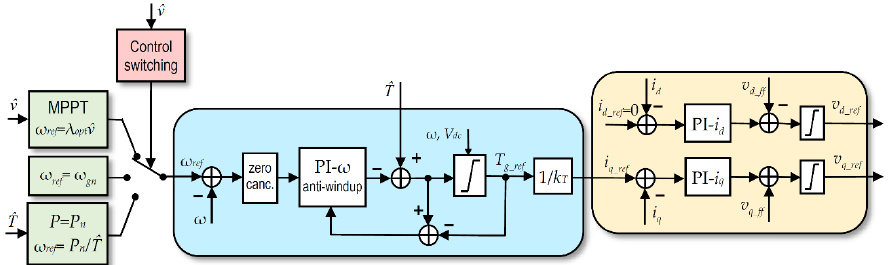
Figure 9. Rotor velocity and current controllers with variable structure setting of ω ref and compensation input of aerodynamic torque estimate T̂ .